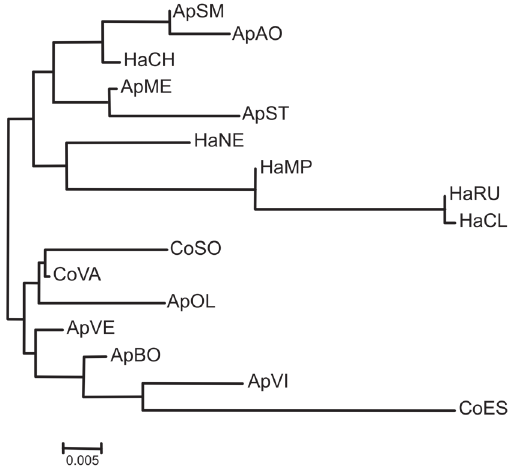
Figure 3. Cacopsylla melanoneura population tree. Unrooted Neighbour-Joining population tree based on Slatkin linearized F ST pairwise matrix.